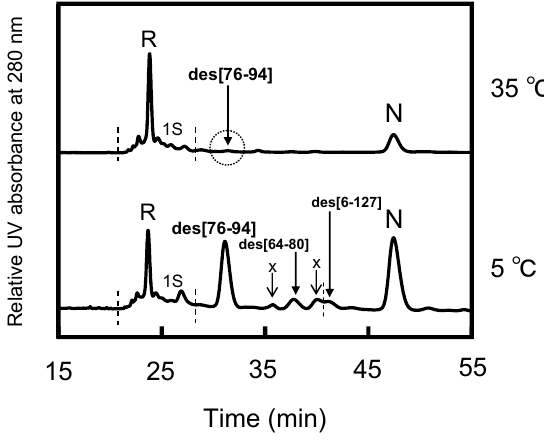
= [DHS ox ] /3 = 10.5 µM at 5 °C and 0 0